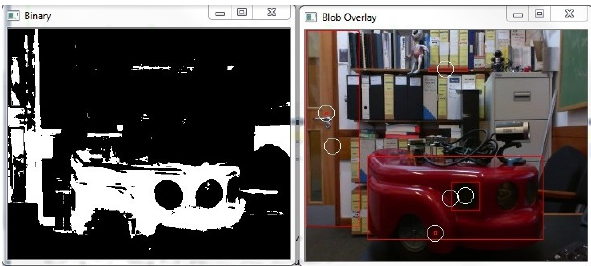
Figure 8: The left image is binary version arising from HSV and RGB segmentation of the original. The right image is original with blobs selected from binary segmentation overlaid. In this instance there is relative good identification of the main object of interest (the red AmigoBot)